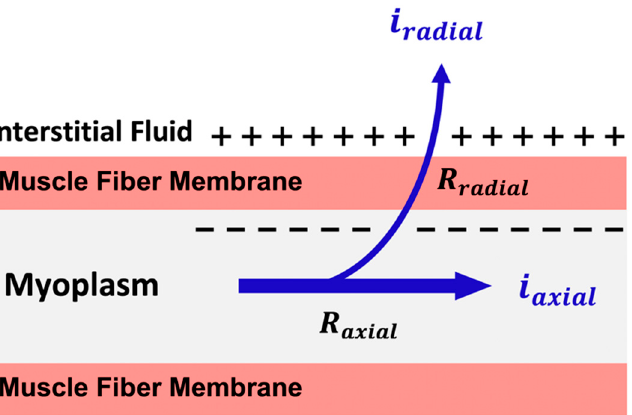
Figure 4. An illustration of the orientations of the axial flow of current (i axial ) and its resistance (R axial ) relative to the outgoing current radially through the muscle membrane (i radial ) and its resistance (R radial ) as both contribute to the capacitive properties of the muscle fiber.